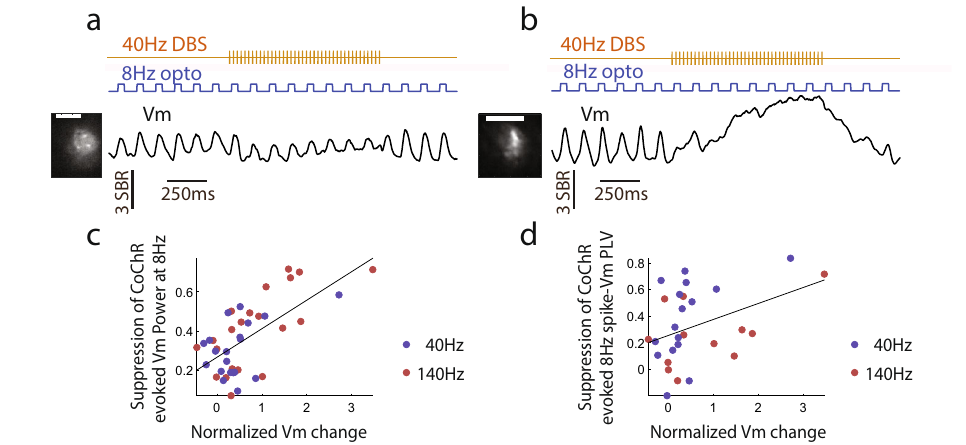
Fig. 8 | DBS-induced membrane depolarization predicts suppression of opto- genetic inputs. a A single neuron example showing the trial-averaged Vm during 8Hz CoChR activation and 40Hz DBS. The Vm has been smoothed with a 30ms rectangularwindowtobetterhighlightthedepolarizationeffectinresponseto8Hz CoChR activation. This neuron exhibited prominent optogenetics-evoked Vm depolarization without DBS, and reduced Vm depolarization during 40Hz DBS. AverageSomArchon fl uorescenceoftheexampleneuronisshownintheleftimage. Scale bar, 15 µ m ( b ) Same as ( a ), but another neuron example with strong Vm depolarization during 40HzDBS. c The reduction ofoptogenetically induced 8Hz VmpowerisshownasafunctionofVmchange(DBS – Baseline)during40Hz(blue